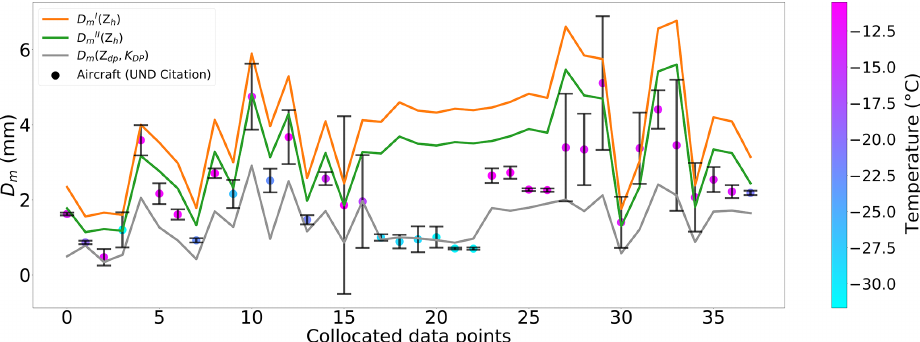
Figure 7. Collocated aircraft in situ data in chronological order (colored dots), the D m power laws (yellow and green), and the D m ( Z dp ,K DP ) retrieval (gray) of RSVP data (solid lines) for 10 flight missions. Vertical bars have the same meaning as in Fig.